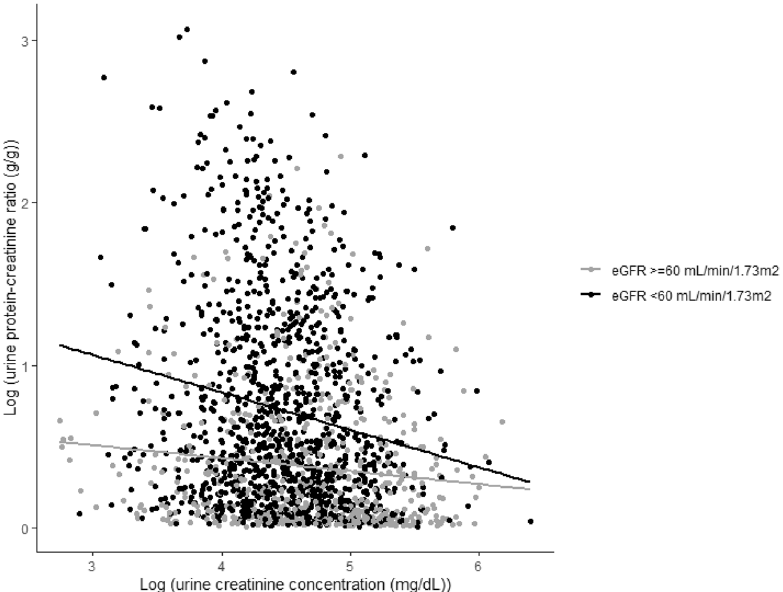
Figure 2. Scatter plot of urine creatinine concentration versus urine protein–creatinine ratio (UPCR; on log– log scales) stratified by estimated glomerular filtration rate (eGFR) category. This shows an inverse correlation between urine creatinine concentration and UPCR in patients with eGFR ≥ 60 or < 60 mL/min/1.73 m 2 . The linear regression is shown as a gray (black) solid line for the former (latter).